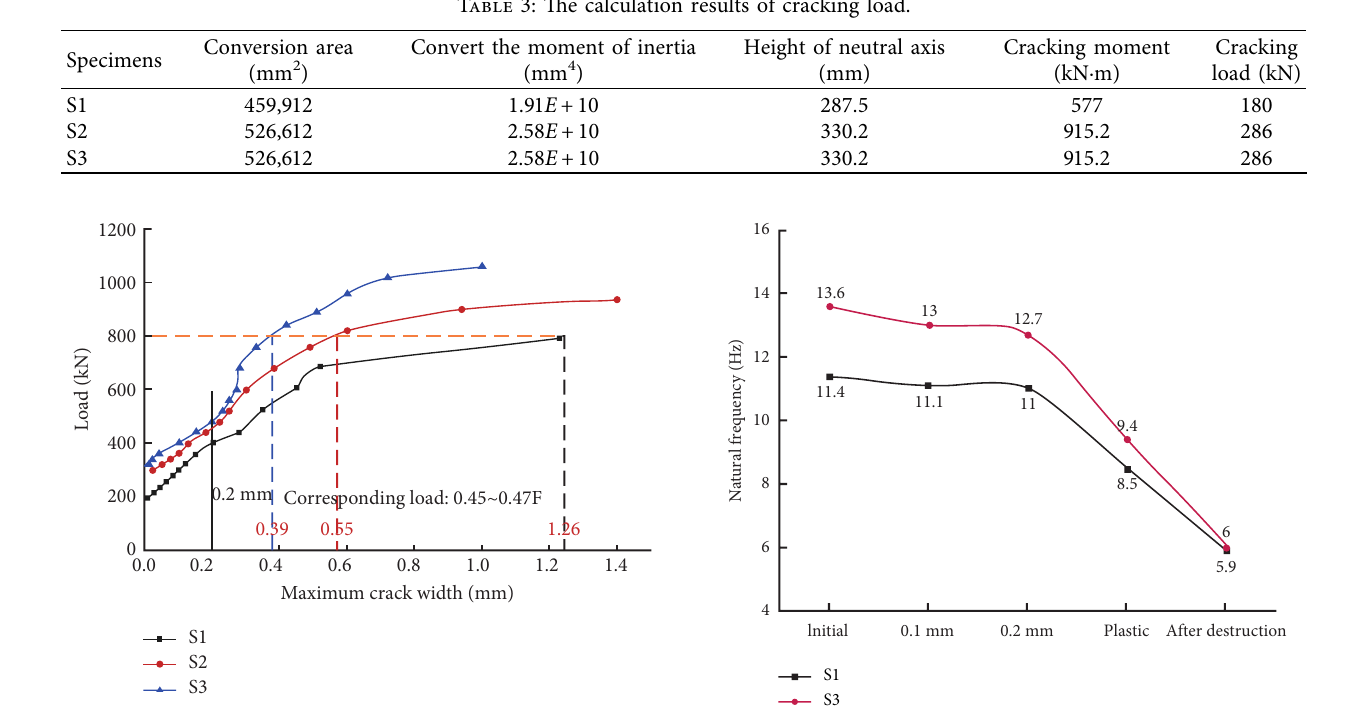
Figure 11: Load-maximum crack width curve.